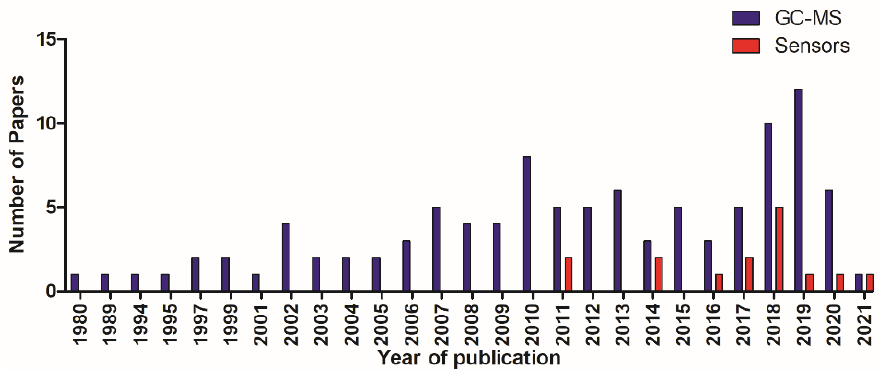
Figure 2. Total number of papers in relation to year of publication.